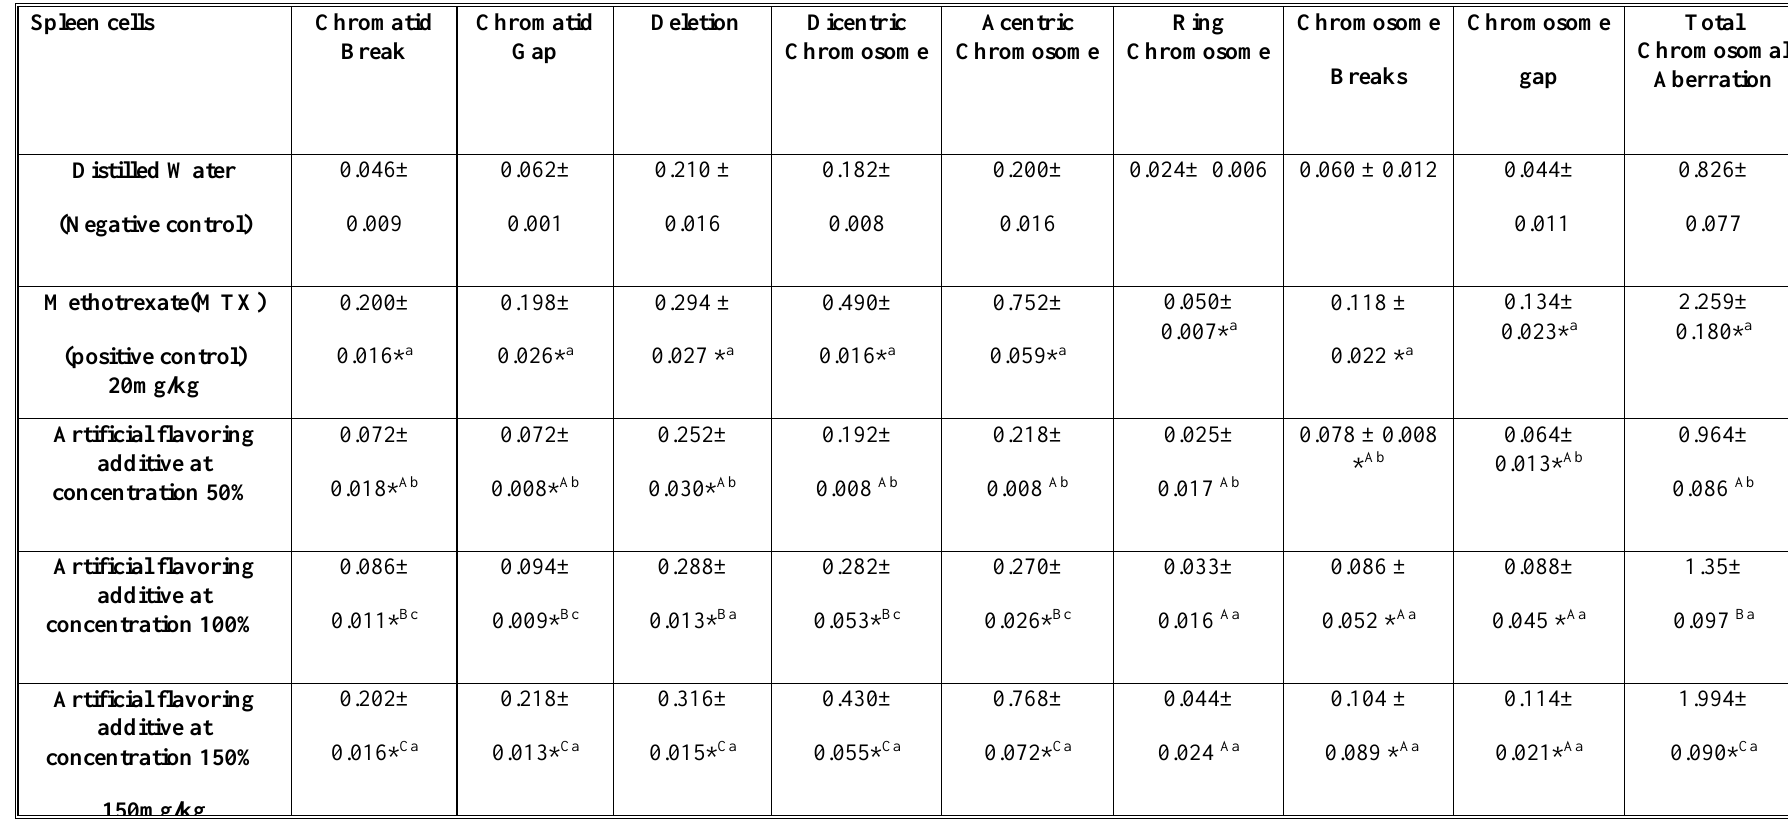
Table 2. Individual and Total chromosomal aberrations in spleen cells after exposure to different concentrations of artificial food flavoring additive in mice . Spleen